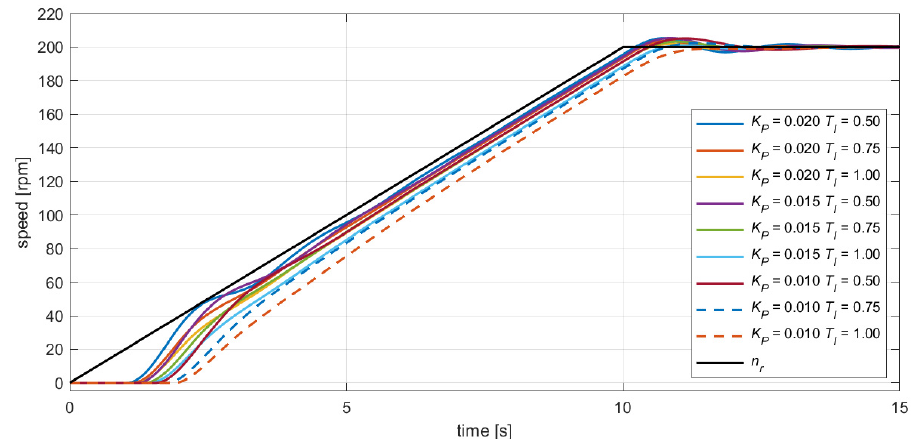
Figure 9. Result of simulation of the waveform of rotational speed, n s , for various parameters of the PI controller.